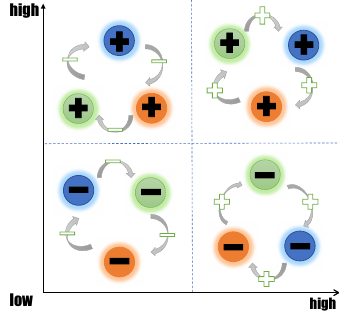
Figure 2. Different patterns